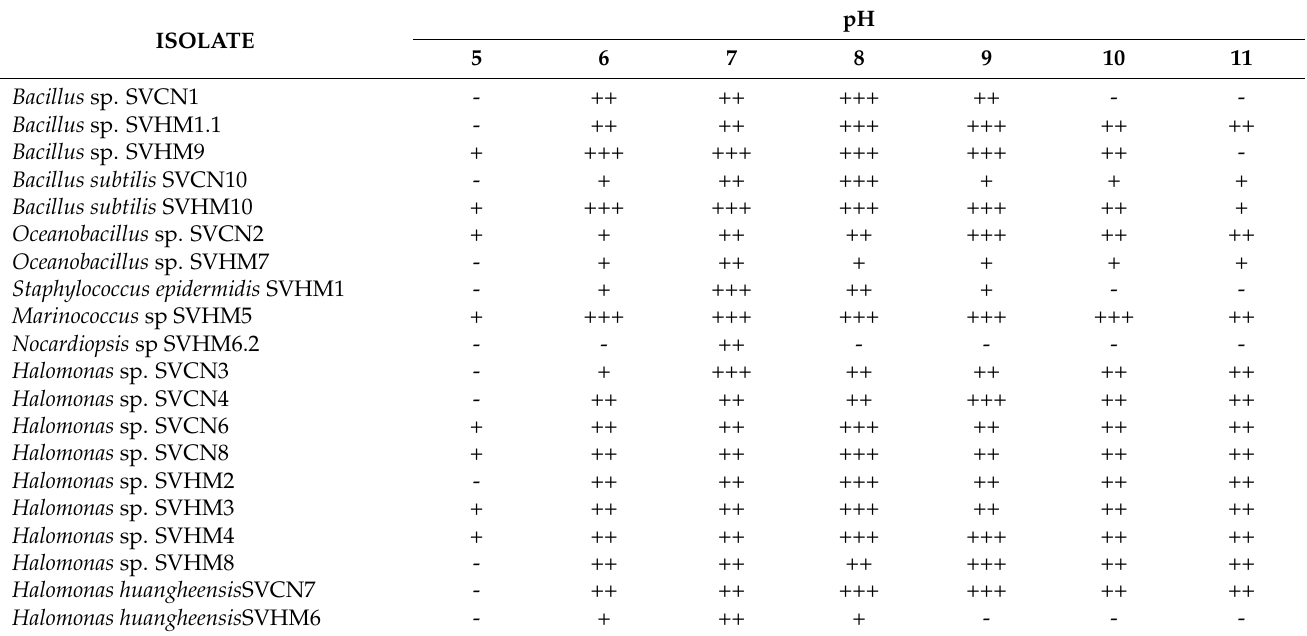
Table 2. Growth of the isolates at different pH